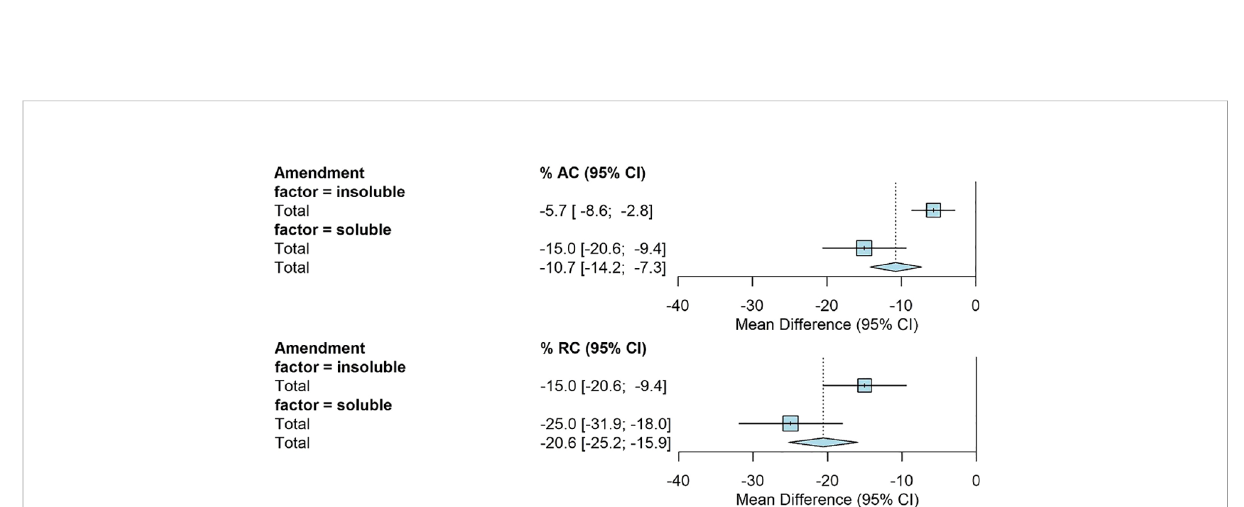
FIGURE 4 Fully random effects forest plot for AC and RC by amendment type. Squares represent average treatment effect for each subgroup with error bars denoting the 95% CI. Diamonds represent the 95% CI of the overall treatment effects.